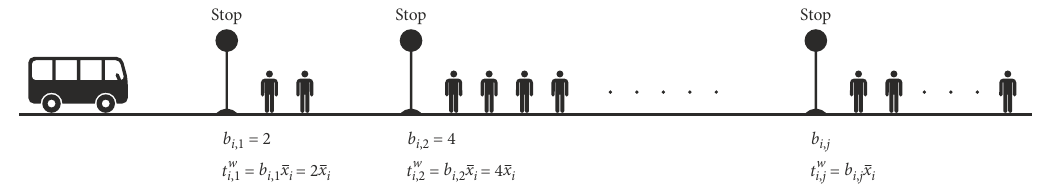
Figure 5. Passenger waiting time